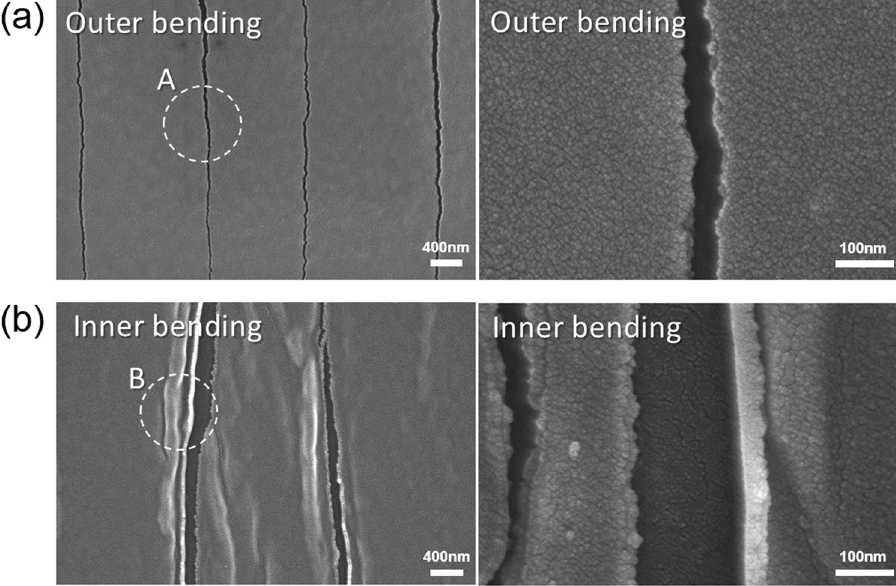
Figure 10. Surface FESEM image and enlarged image of the SnO 2 /APC/SnO 2 multilayer after the ( a ) outer bending (2 mm) and ( b ) inner bending (1 mm) tests beyond the critical bending